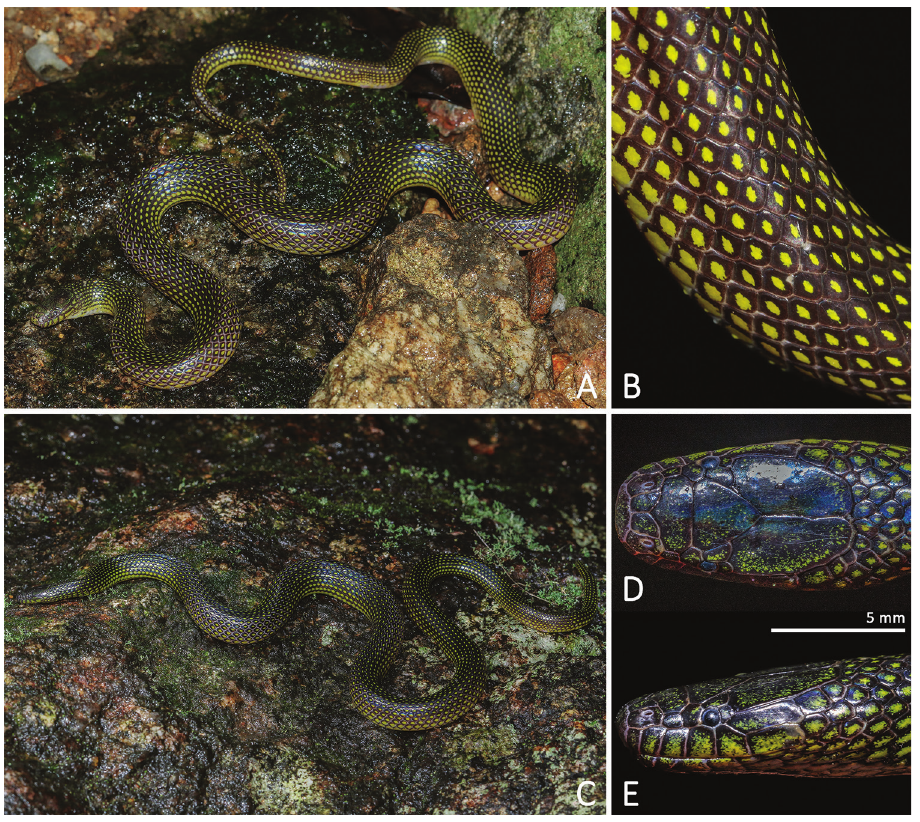
Figure 6. Morphological features of the adult female paratypes of Opisthotropis hungtai sp. nov. from Dawuling Forestry Station, Guangdong, China. A, B Habitus view and close-up of mid-dorsal body of SYS r001515 C–E habitus view and close-up of head scales of SYS r002017. Photos by Jian Wang.